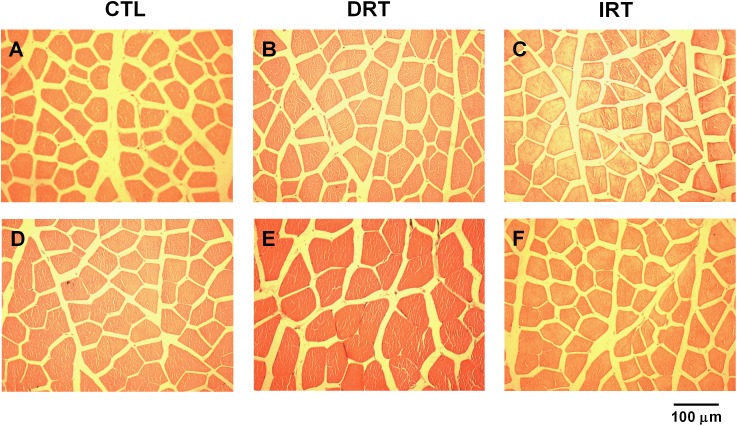
Representative photomicrographs of muscle sections. Hematoxylin-eosing staining. Panels A–C present the cross-sectional area of the tibialis anterior muscle. Panels D–F present the cross-sectional area of the quadriceps muscle. Magnification 200×, (n = 5 rats per group).